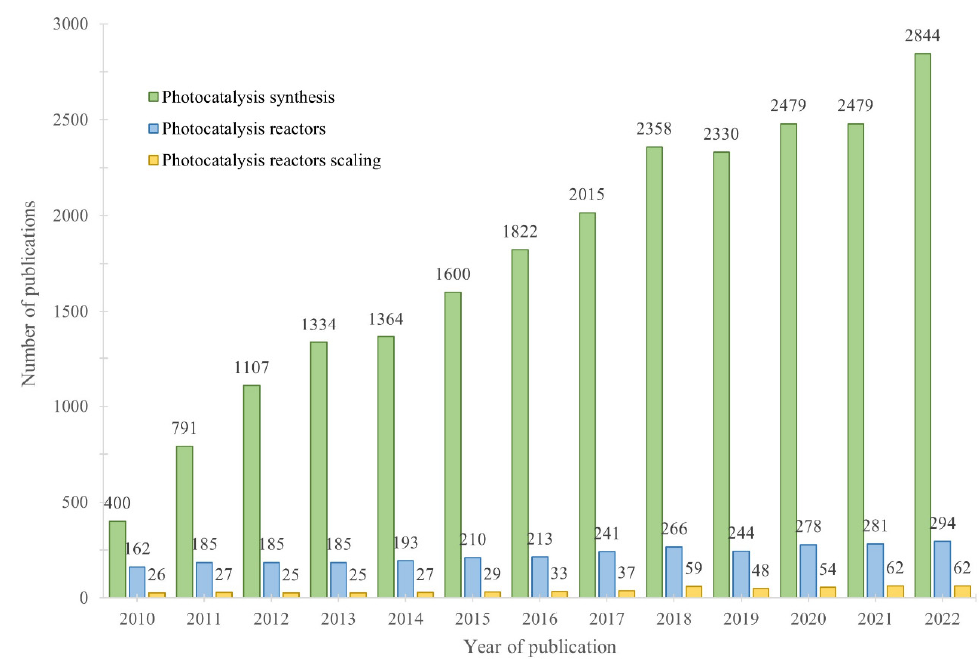
Figure 2. Comparison of the number of published studies on the synthesis of new photocatalysts (green bars), the development of photoreactors (blue bars), and the upscaling of the heterogeneous photocatalysis process (yellow bars). The search of the publication was performed in Scopus using the keywords “photocatalysis” + “synthesis”, “photocatalysis” + “reactors”, and “photocatalysis” + “reactors” + “scaling”.